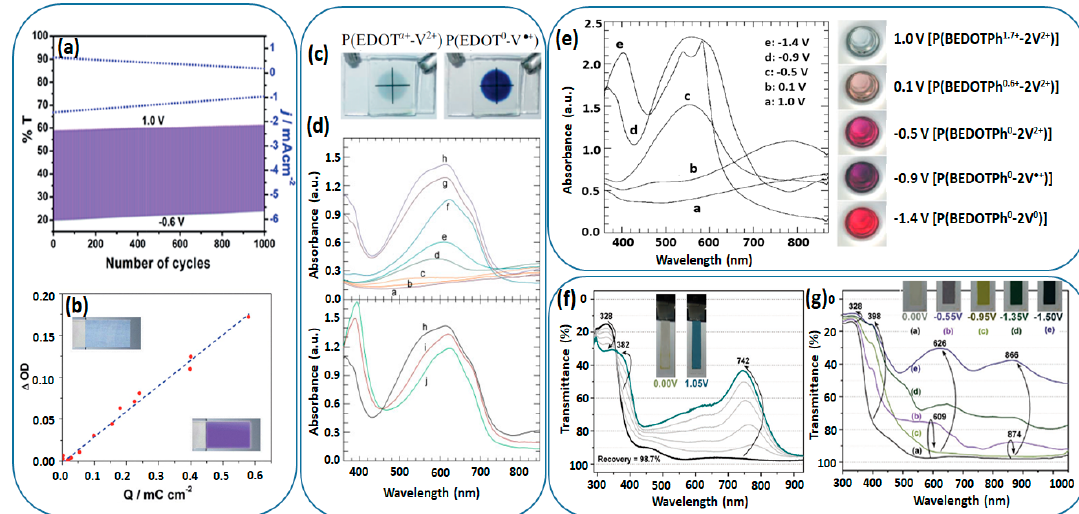
Figure 11. ( a ) Cycling stability test for electrochromic PTh-V at bleached (1.0 V) and colored ( − 0.6 V) states. The dotted line refers to the current change, and the solid line below refers to the transmittance change. ( b ) Optical density change (DOD) of the PTh-V film at 610 nm as function of charge density (Q) at different applied potentials ranging from 1.0 to − 0.6 V. ( c ) Photograph of an ECD based on P(EDOT-V) film. ( d ) Spectroelectrochemical graphs of P(EDOT-V) film on ITO glass at various applied potentials: (a) 0.5 to 1.2 V, (b) 0.2 V, (c) 0 V, (d) − 0.2 V, (e) − 0.4 V, (f) − 0.6 V, (g) − 0.7 V, (h) − 0.8 to − 1.0 V, (i) − 1.2 V and (j) − 1.4 to − 1.6 V versus Ag / Ag + . ( e ) Electronic absorption spectra of the